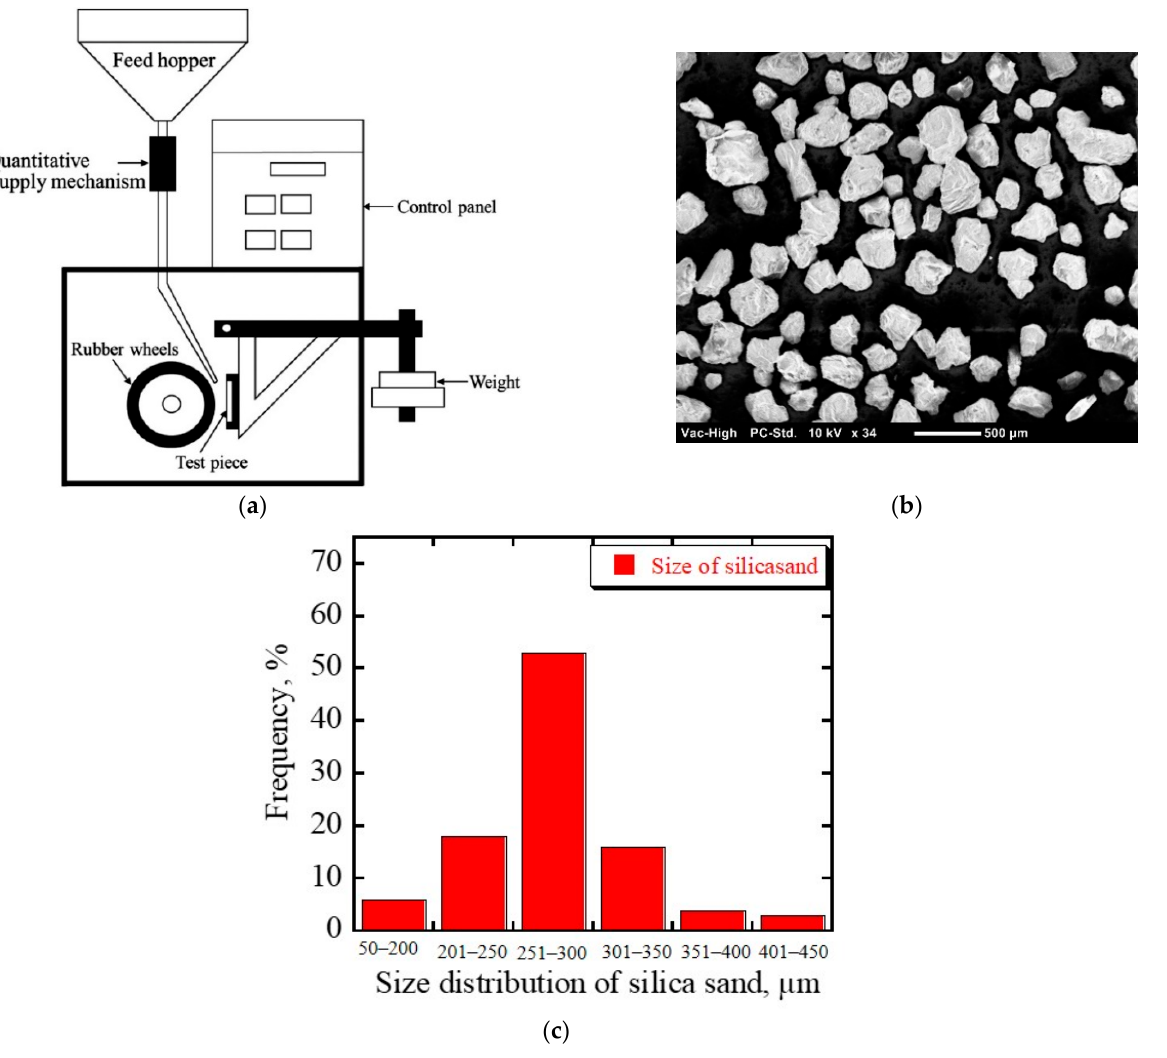
Figure 2. ( a ) The schematic of the rubber wheels three abrasive wear machine test according to ASTM G65; ( b ) Silica sand or abrasive particles; ( c ) The distribution of abrasive particles.